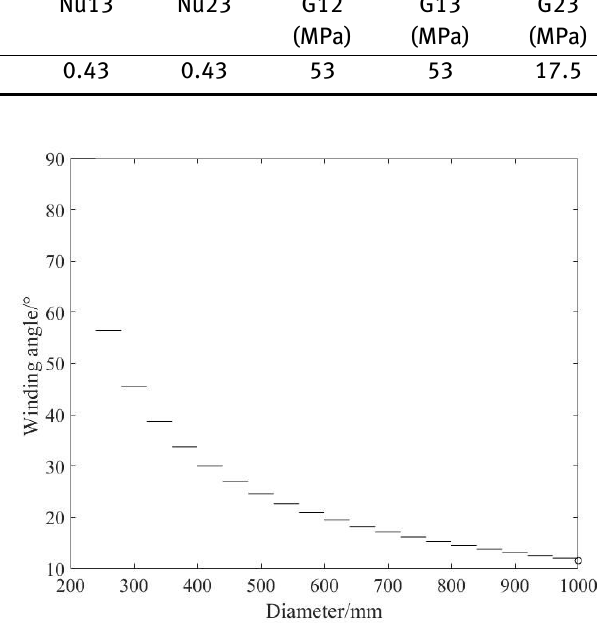
Figure 9: The distribution of winding angles